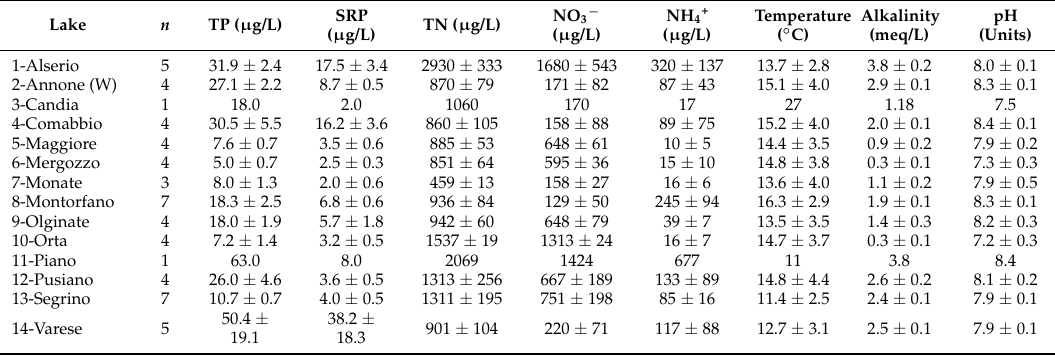
Table 2. Mean value ± SEM of the chemico-physical parameters of the 14 lakes, calculated on measurements performed in different months. Note that for Lake Candia and Piano the values refer to a single month. n : number of experiments performed for each